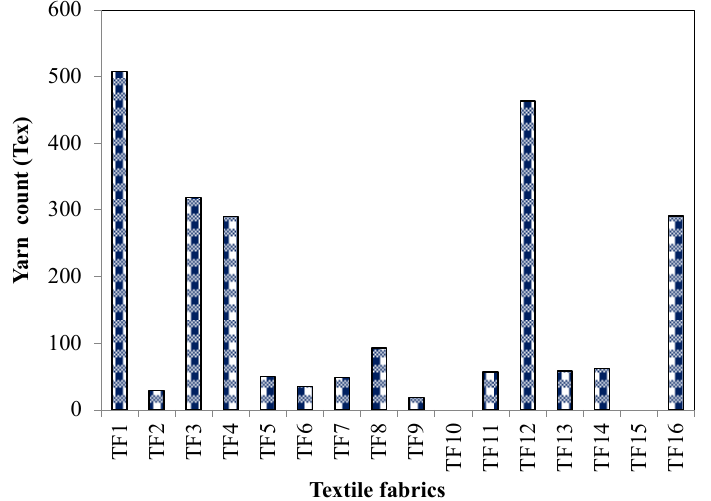
Figure 11. Yarn count of tested fabric specimens.